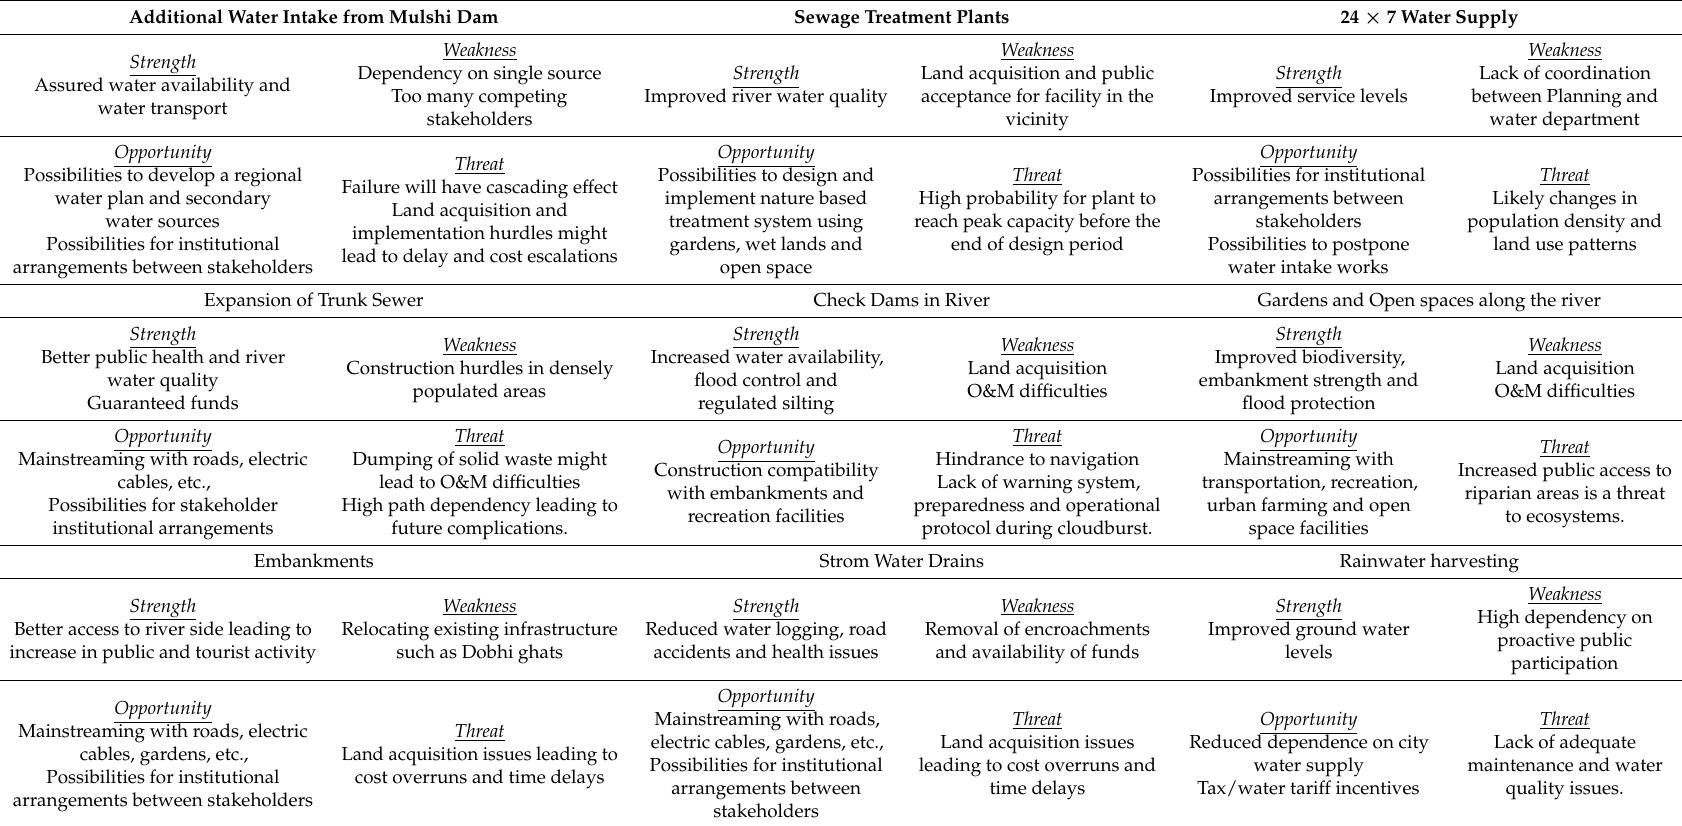
Table 3. SWOT analsysis of Adaptation